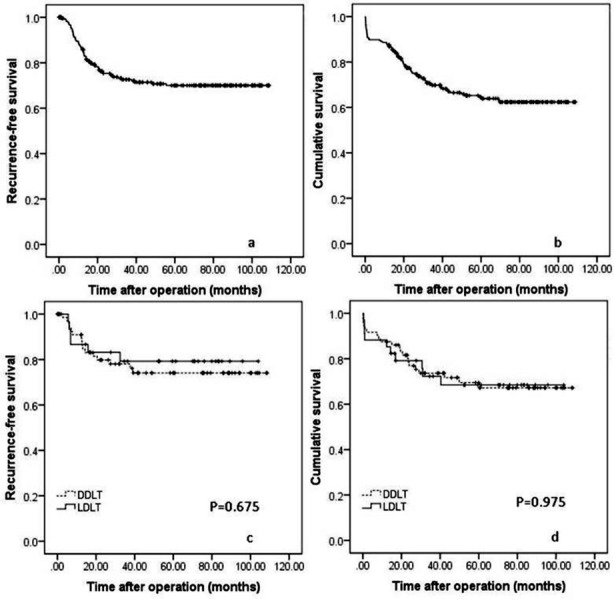
RFS (Fig.1a) and OS (Fig.1b) curves of all patients. Comparison of the RFS (Fig.1c) and OS (fig.1d) rates of LDLT and DDLT for patients with HCC within Milan criteria.